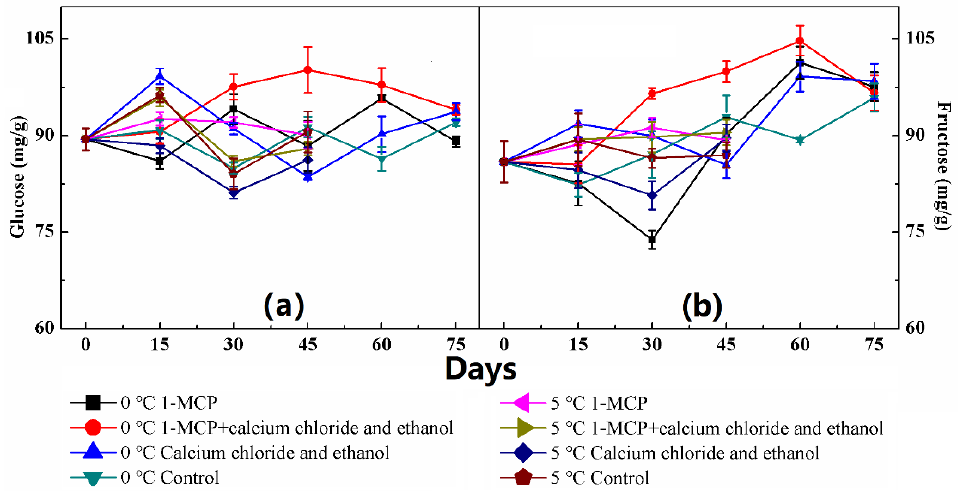
Figure 4. Dynamic changes of glucose ( a ) and fructose ( b ) value of grape pulp. The data is presented as mean ± standard error (SE) of at least three repetitions. as mean ± standard error (SE) of at least three